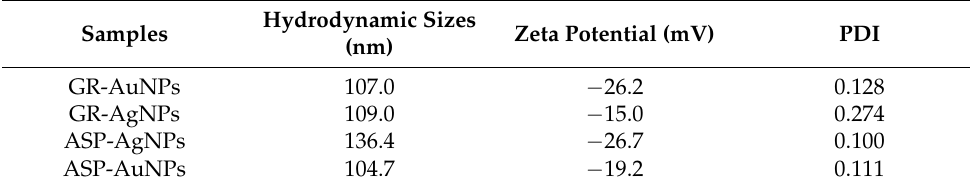
Table 1. DLS analysis, particle sizes, zeta potential, and polydispersity index of the MNPs under